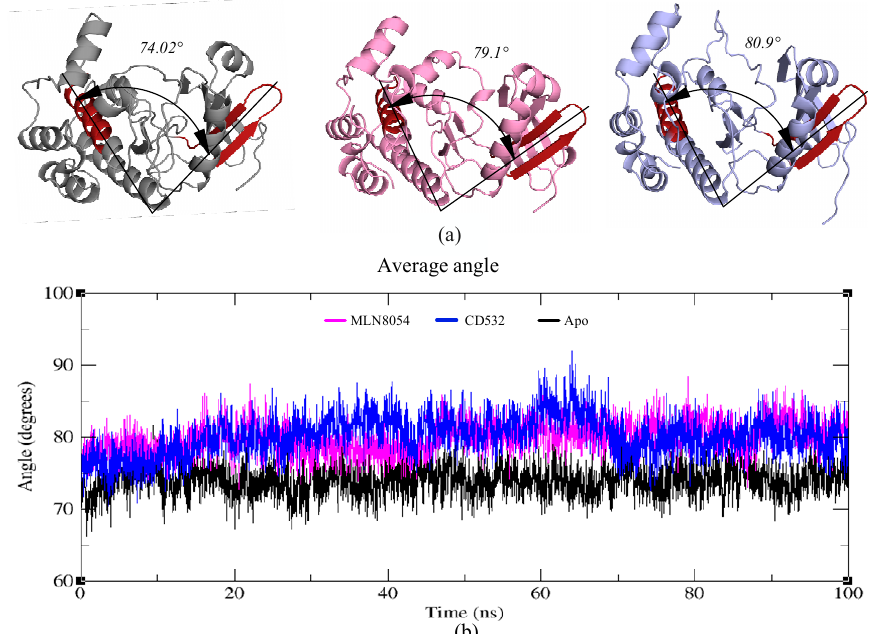
Figure 7. ( a ) Representation of the crystal structures of apo-Aurora-A (4J8N, black), Aurora-A with MLN8054 (2WTV, pink), and Aurora-A with CD532 (4J8M, blue). The angle between two vectors joining the α -carbons Leu196 to Leu210 (in the red hairpin), and Val310 to Val324 (red α -helix), is shown and labeled. ( b ) the plot represents the angle value during the trajectories of Aurora-A for 100 ns MD simulations.